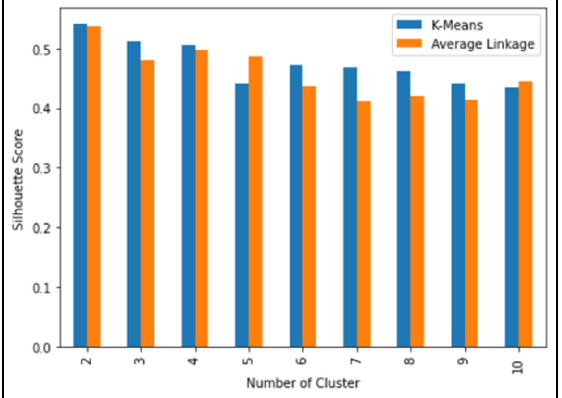
Fig. 3. Silhouette score of KM and